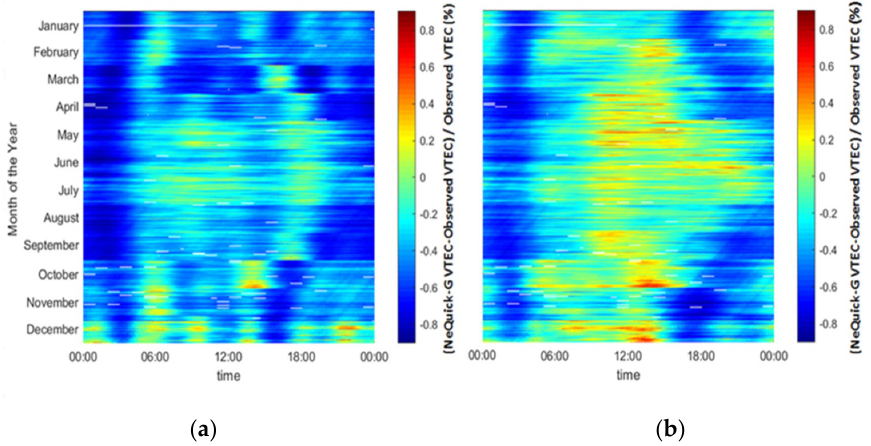
Figure 3. Comparison of relative difference (NeQuick-G VTEC-Observed TEC)/Observed TEC (%) between measured VTEC data over Cyprus and corresponding estimations using NeQuick-G with ( a ) Cyprus (long-term) CCIR files and ( b ) Standard CCIR files.